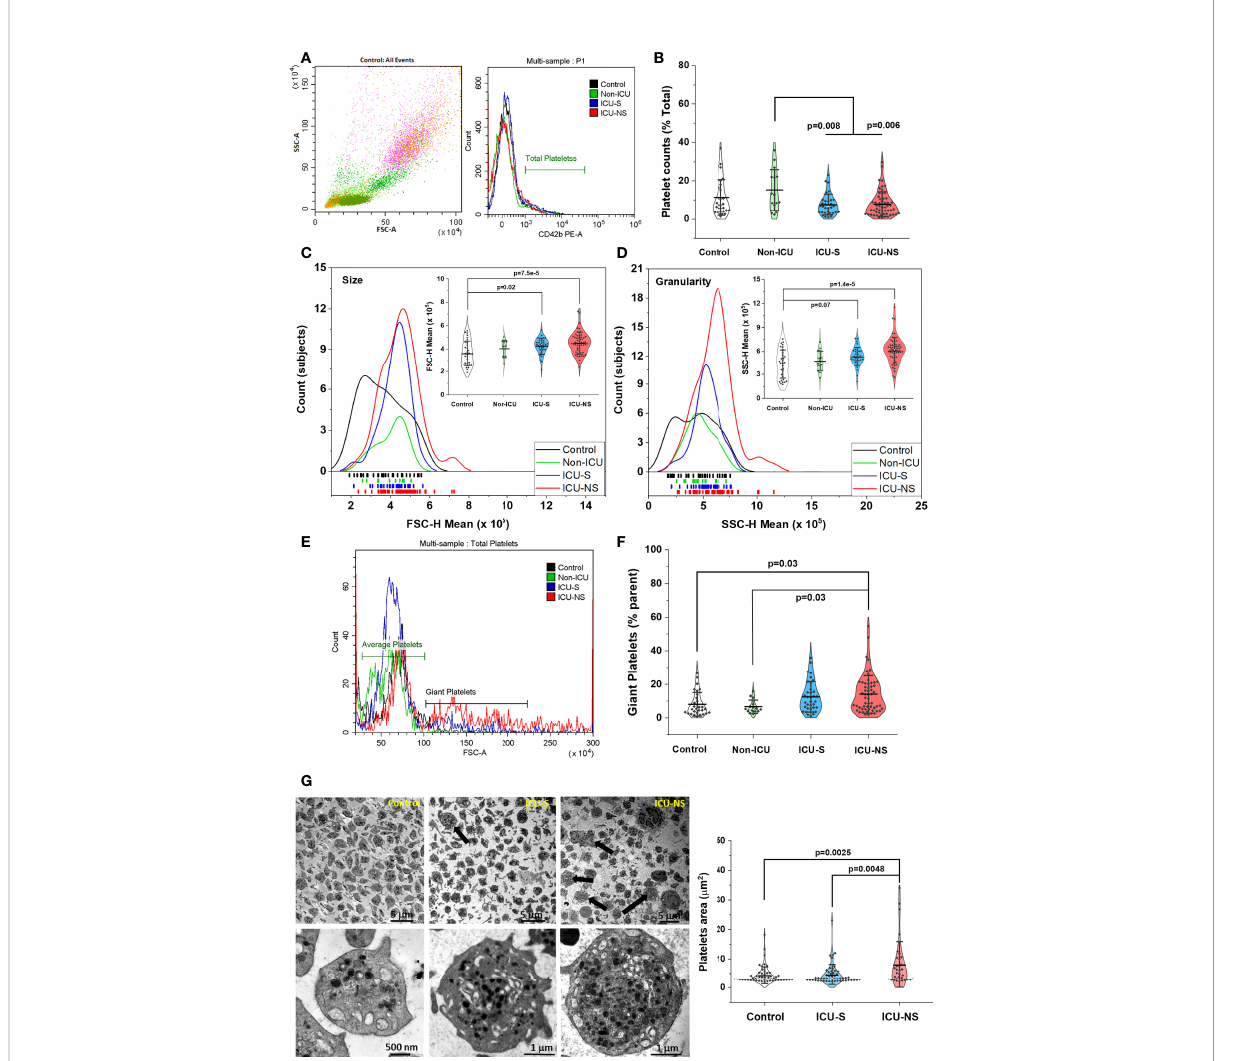
FIGURE 1 Increased size, granularity, and giant platelets counts are hallmarks in severe COVID-19 patients. Identi fi cation of platelets, determination of their counts, size and granularity by whole blood fl ow cytometry. A discriminator is set to only record events that express a platelet-speci fi c marker (i.e., CD42b). Events are double gated for characteristic light scatter and platelet-speci fi c marker; CD42b expression (A) . (B) A scatter and violin diagram showing statistically signi fi cant decrease in platelet counts of ICU-hospitalized (survivors, and non-survivors) when compared to non-ICU (mild+moderate) patients (n=31, 15, 34, and 56 for control, non-ICU, ICU-S, ICU-NS; respectively). (C) A distribution and rug plot showing a systematic increase in the mean platelet size with COVID-19 severity. A violin plot within (C) showing a statistically signi fi cant increase in the mean FSC (platelet size) in ICU-hospitalized patients relative to control group (n=31, 15, 35, and 57 for control, non-ICU, ICU-S, ICU-NS; respectively). (D) A diagram revealing increased granularity in platelets of non-survivors relative to control platelets (n=31, 15, 35, and 57 for control, non-ICU, ICU-S, ICU-NS; respectively). (E) Representative fl ow cytometric histograms comparing populations of giant platelets for all groups. (F) When the percentage of giant platelets were compared for all groups, non-survivors ’ platelets comprises signi fi cantly larger subset of giant platelets (n=30, 15, 35, and 56 for control, non-ICU, ICU-S, ICU-NS; respectively). (G) Representative TEM images for all groups, showing ultrastructural features of peripheral blood cells in fi elds populated with platelets. The upper-right image and quanti fi cation panel revealed more frequently observed giant platelets in the ICU-NS group (n=3 of each group and analyzed platelets = 54, 53, 34 for control, ICU- S, and ICU-NS; respectively). Also, platelets exhibited morphological changes from a resting discoid shape in control subjects to an activated state with numerous pseudopodia in severe COVID-19 patients. Additional images are given in Supplementary Figure S3. Multiple comparisons were carried out using ANOVA followed by Tukey test and p values are given. Data plotted as mean ±